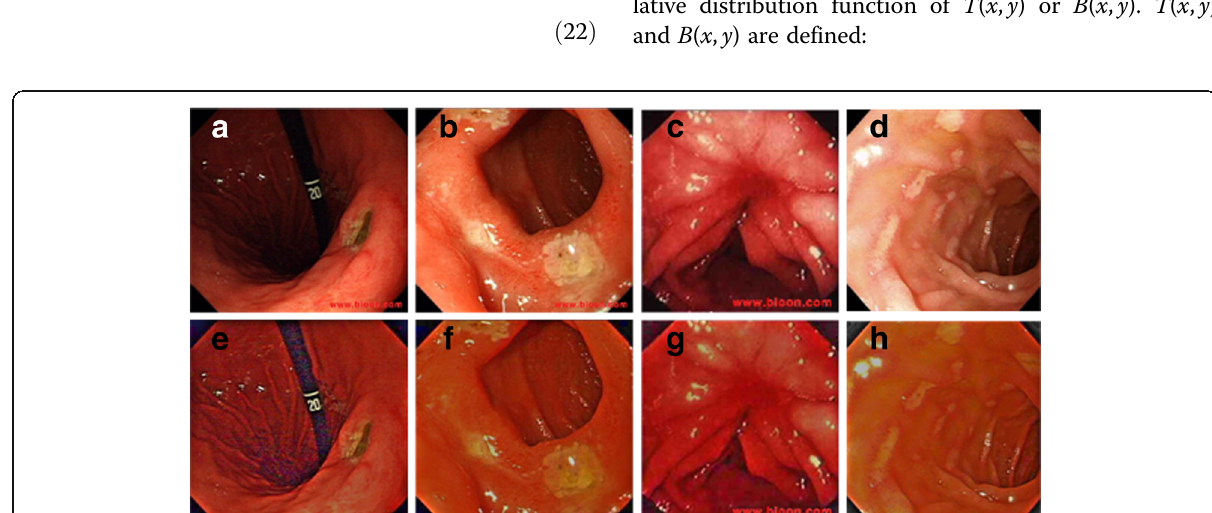
Fig. 6 AD- L 1 L 2VR results of endoscopic images. a – d original images. e – h AD- L 1 L 2 VR results of ( a – d )